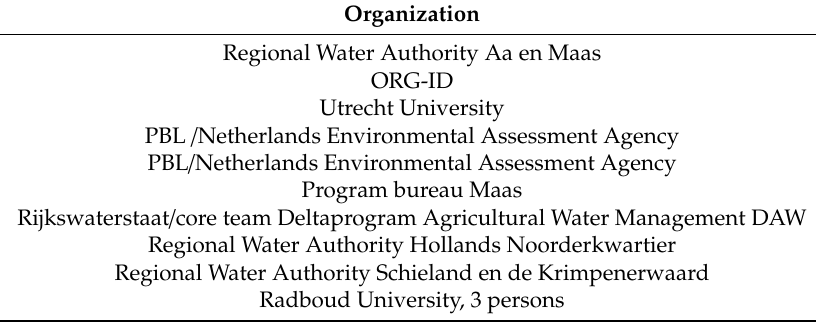
Table A4. Participants Reflection Workshop 6 February 2019 (Made